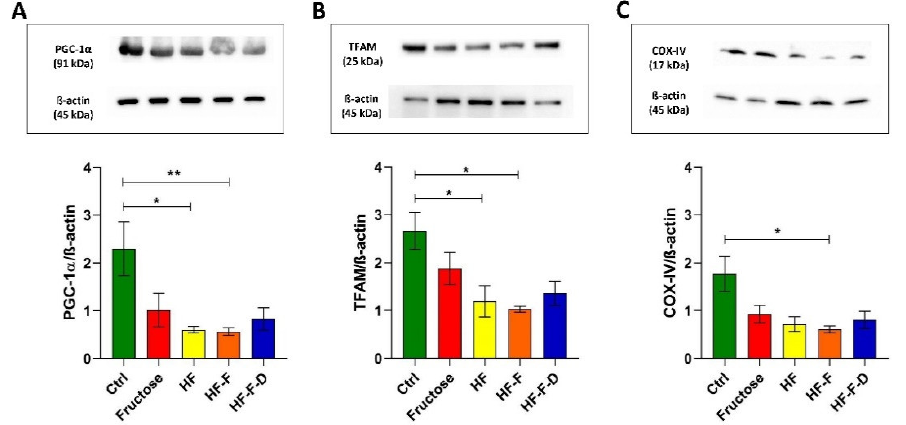
Figure 3. Western blot analysis of PGC-1α ( A ), TFAM ( B ), COX-IV ( C ) in liver samples from Ctrl, Fructose, HF, HF-F, and HF-F-D rats, with each group consisting of four rats. Data were analyzed by Kruskal–Wallis analysis of variance and Dunn’s Multiple Comparison Test (* p < 0.05; ** p < 0.01).